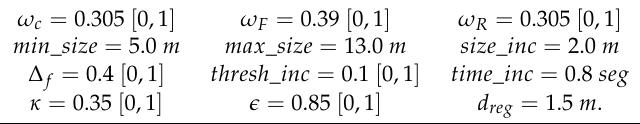
Table 2. Parameters employed in the exploration